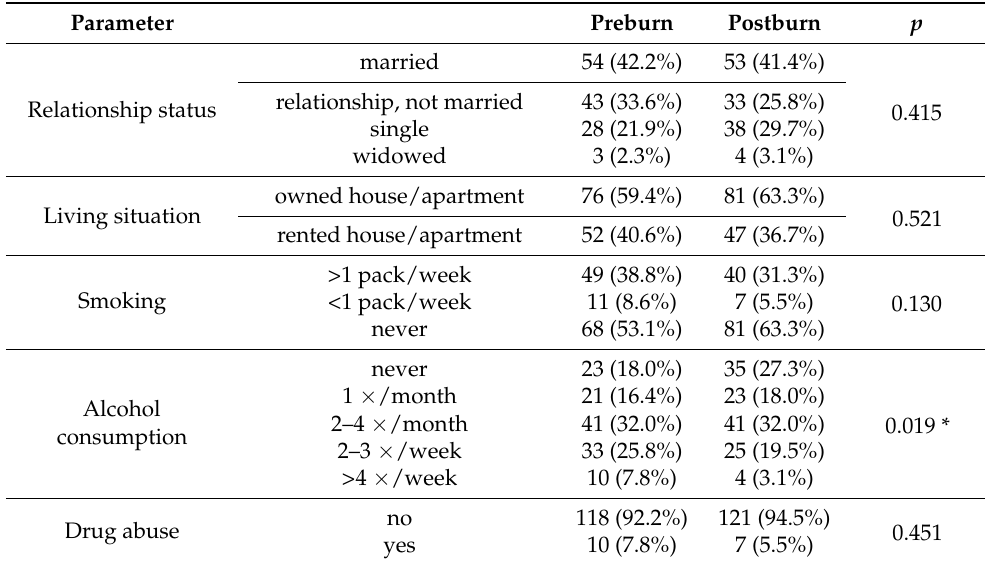
Table 3. Relationship status, living situation, smoking, alcohol consumption, and substance abuse pre- and postburn. * = significant.